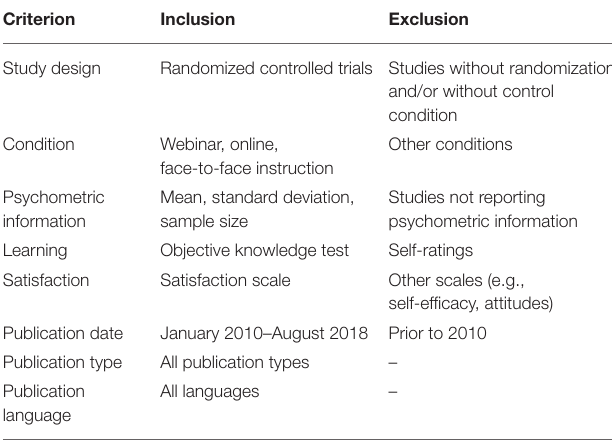
TABLE 1 | Inclusion and exclusion